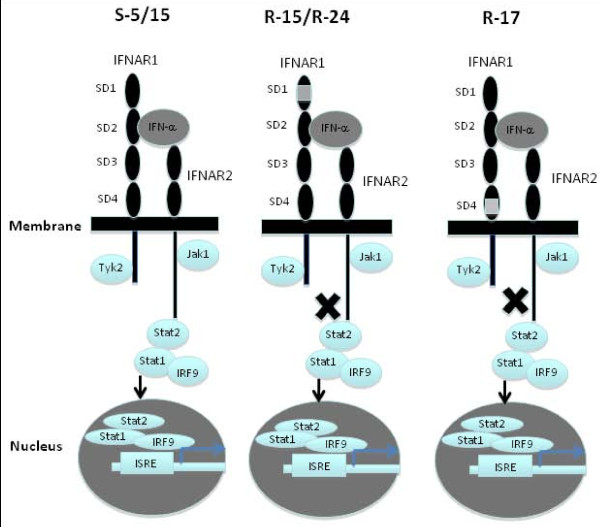
Schematic diagram summarizing the amino acid deletion of extracellular domain of IFNAR1 protein found in the IFN-α resistant Huh-7 cells. Left panel: Four extracellular domains of IFNAR1 in the sensitive cell line with no deletion. Middle panel: 58 amino acid deletions in the SD1 domain in the R-15 and R-24 series clones. Right panel: 50 amino acid deletions in the SD-4 domain of the R-17 series clones. The three series of cell lines demonstrate different variants of IFNAR1 and how the signaling is blocked due to the deletion of extracellular domains of IFNAR1.